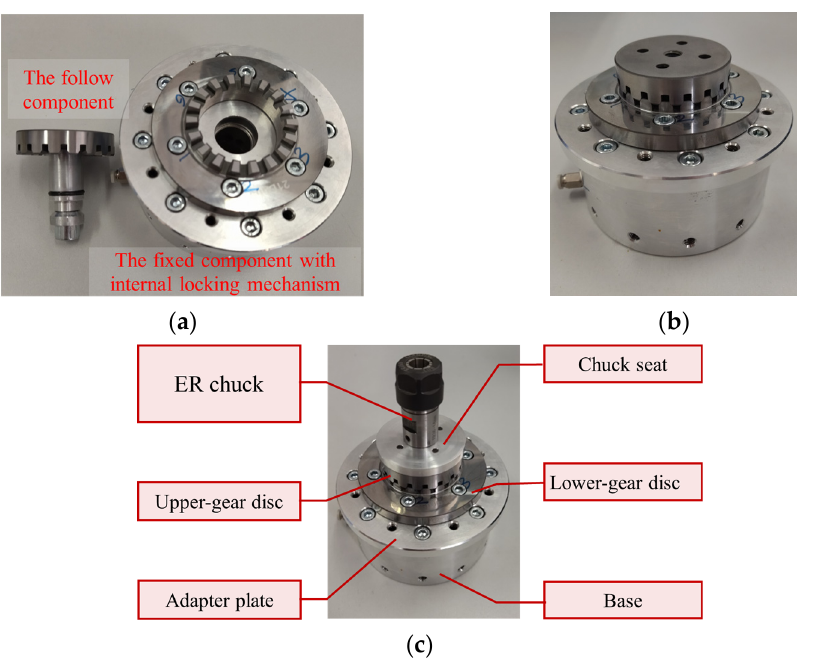
Figure 9. The fabricated quick-change fixture. ( a ) Unlocking state; ( b ) locking state; ( c ) the final in- stallation configuration.